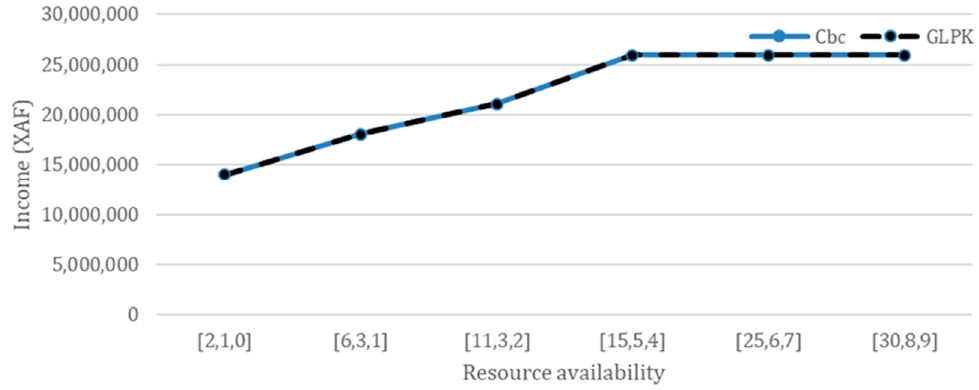
Figure 3. Variation of income according to the availability of resources in scenario 1.